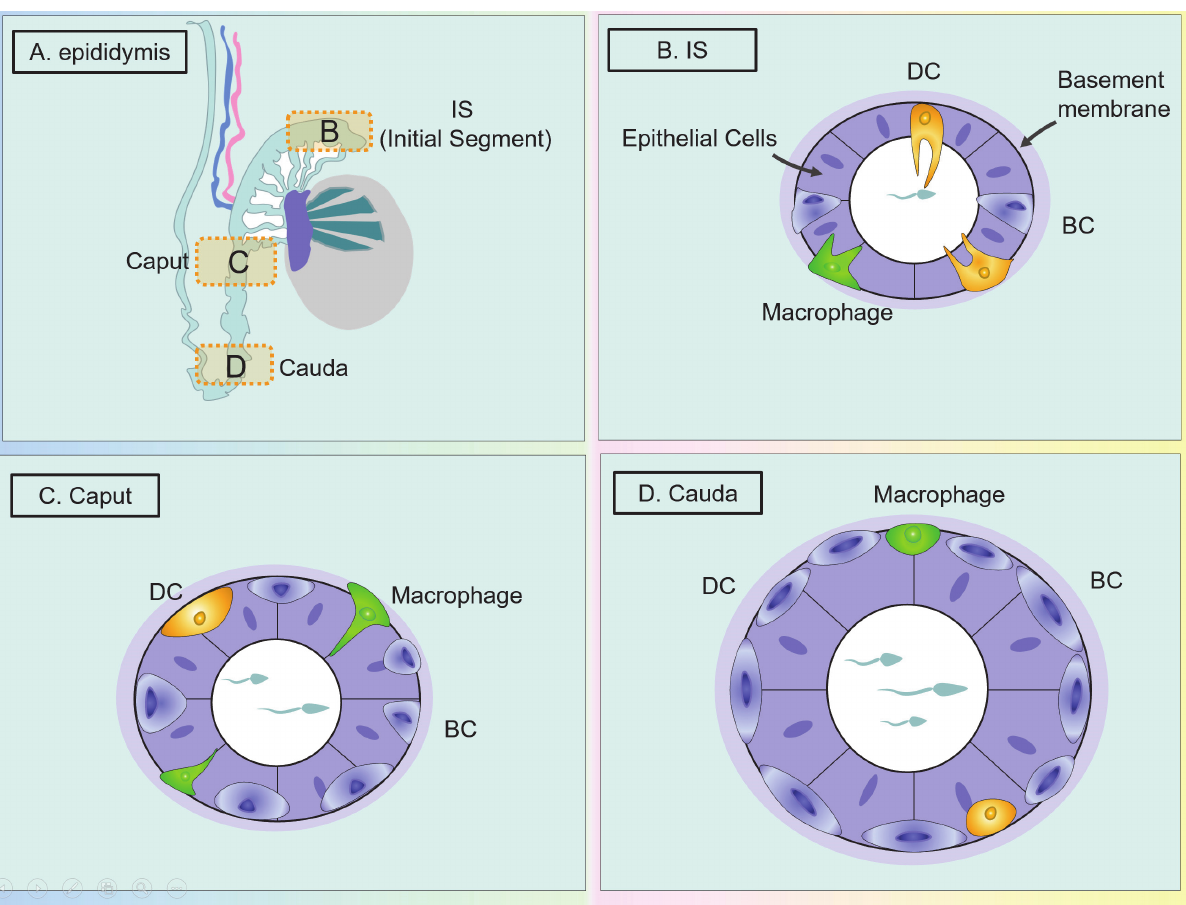
Figure 4. Morphological changes of immune cells in different segments of the epididymis. Marking mouse epididymal BCs, macrophages, DCs with KRT, F4/80 and CD11c. ( A , B ) In the IS, the BCs are located at the base of the epithelium and occasionally send out single, narrow dendrites into the lumen. However, each macrophage and peritubular DC extended a large number of intraepithelial dendrites, mainly located on the epithelial side of the basement membrane. BCs show a characteristic pyramid shape, while the dendrites of DC are slender. The location and morphology of macrophages in the epididymis are similar to DCs. In human epididymis, unlike in mouse epididymis where a dense network of DCs is localized in the epithelium, DCs are identified in the interstitial compartment of the epididymis (not shown). ( C ) In the caput and beyond, BCs and DCs no longer extend out of dendrites. Only macrophages emit short dendrites at the proximal end of the caput. ( D ) In the cauda, DCs are scattered at the bottom of the epithelium, while BCs form a continuous network. (BC: basal cell; DC: dendritic cell; IS: initial segment).